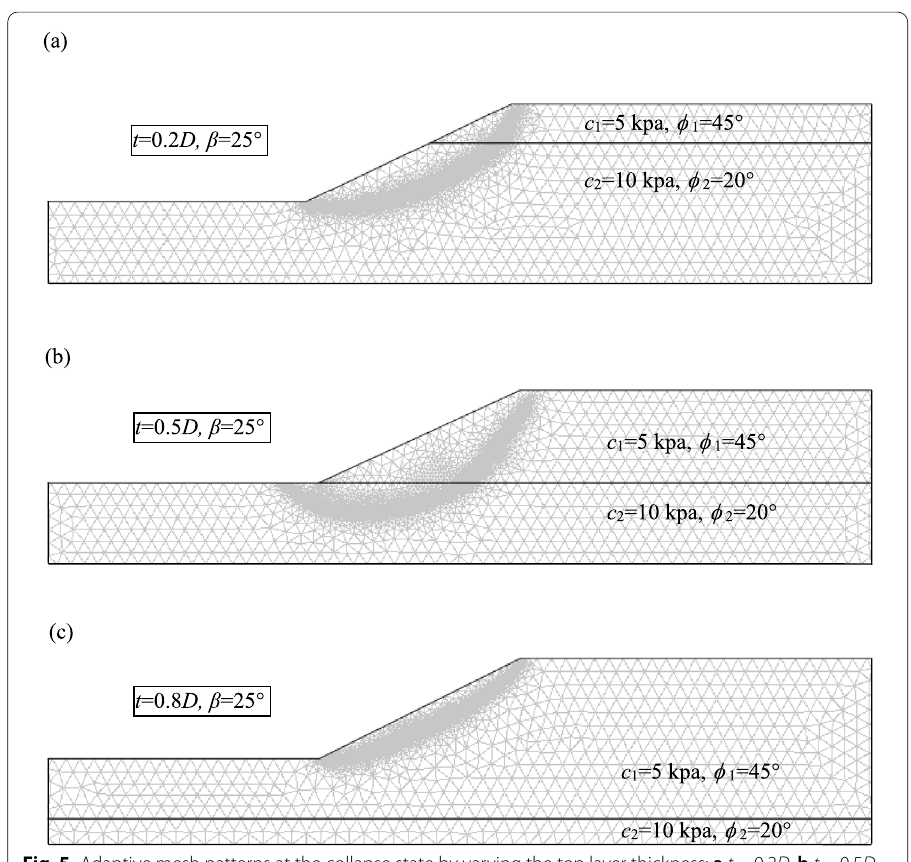
Fig. 5 Adaptive mesh patterns at the collapse state by varying the top layer thickness: a t and c t 0.8 =